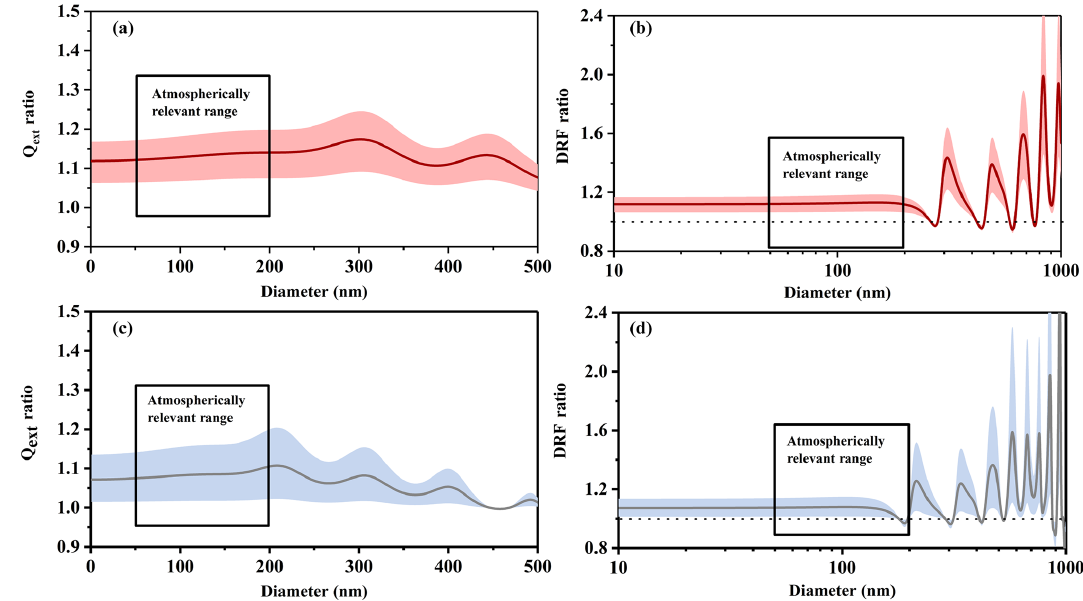
Figure 7. The light extinction efficiency ratio ( Q ext ratio) and the direct radiative forcing ratio (DRF ratio) of n -dodecane SOA under different temperature conditions. (a) Q ext ratio at 532nm; (b) DRF ratio at 532nm; (c) Q ext ratio at 375nm; (d) DRF ratio at 375nm. The solid line represents the average value of the ratio, and the shaded area represents the